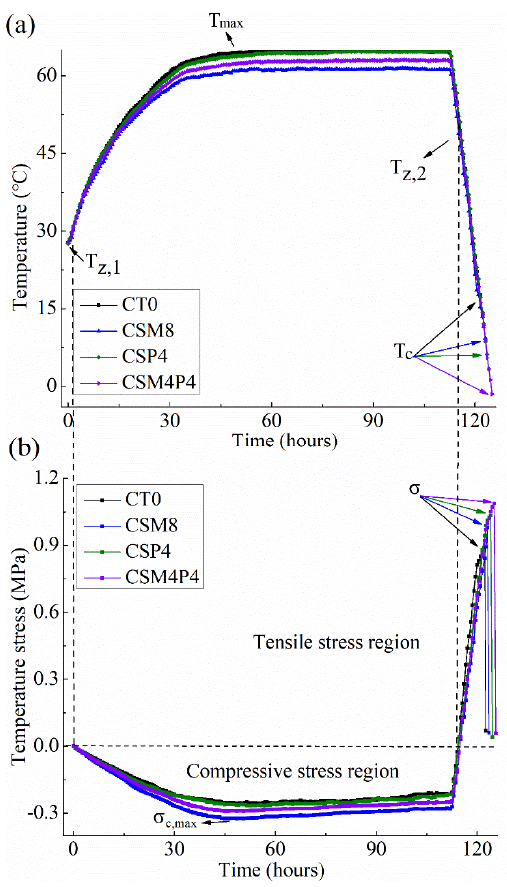
Figure 7. A typical example of TSTM curves of the CT0, CSM8, CSP4 and CSM4P4 concretes: ( a ) the internal temperature development and ( b ) the maximum compressive stress σ c,max , cracking tensile stress σ and cracking temperature T c development